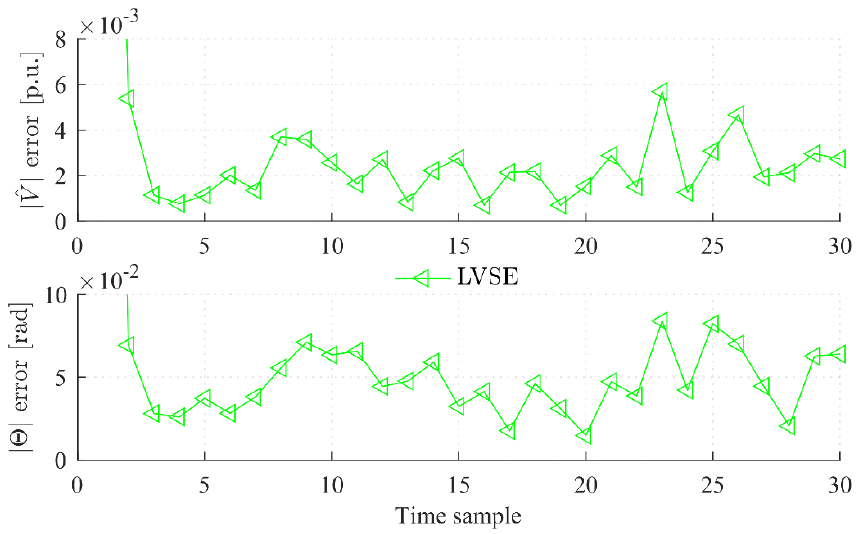
Figure 15. Estimation error — case 4.